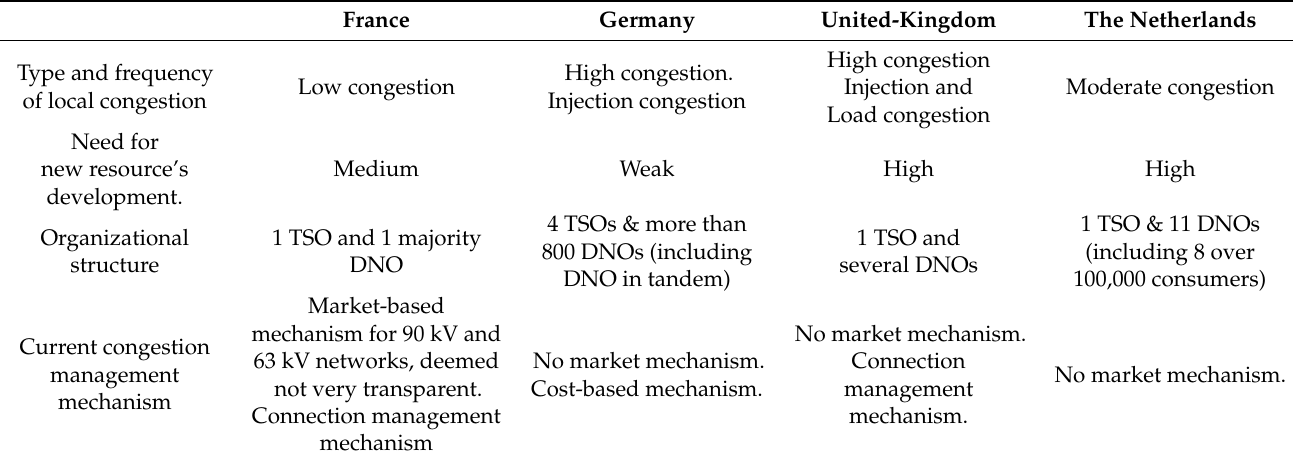
Table 2. Summary of the diversity of situations in different